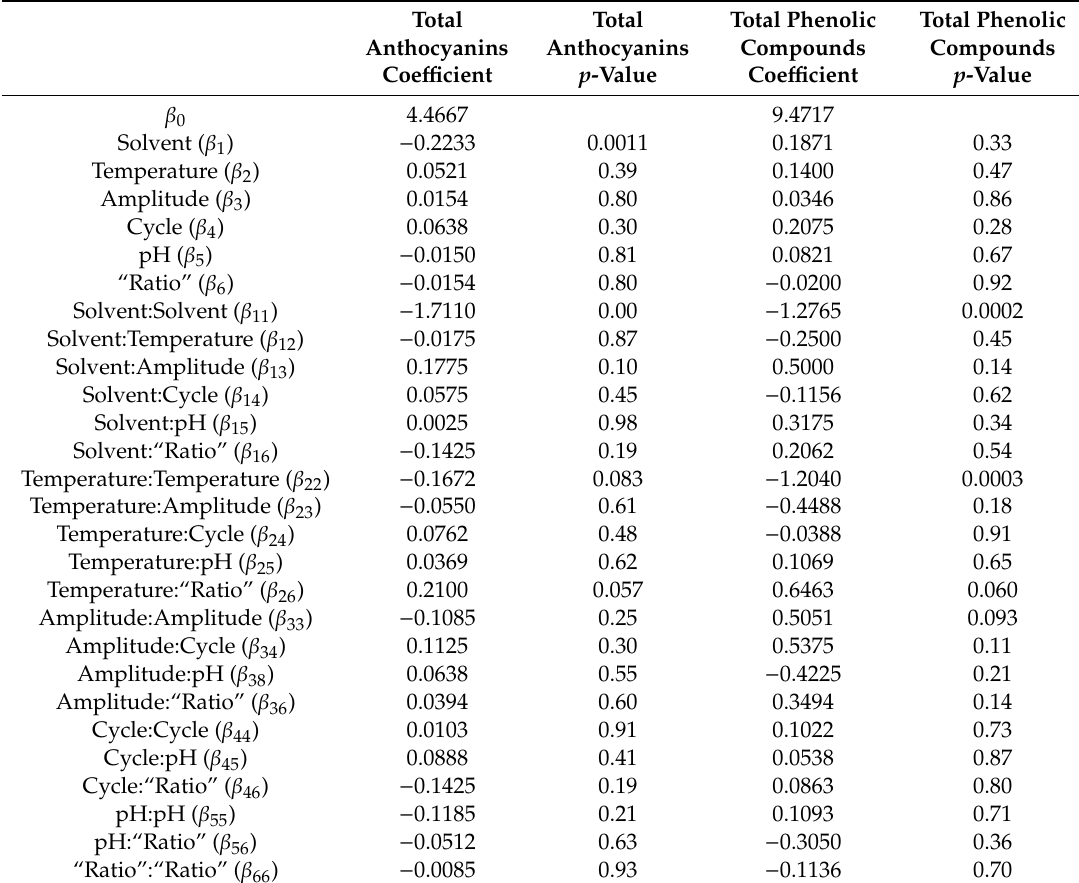
Table 1. Box Behnken Design (BBD) coe ffi cients for total anthocyanins (TA) and total phenolic compounds (TPC).